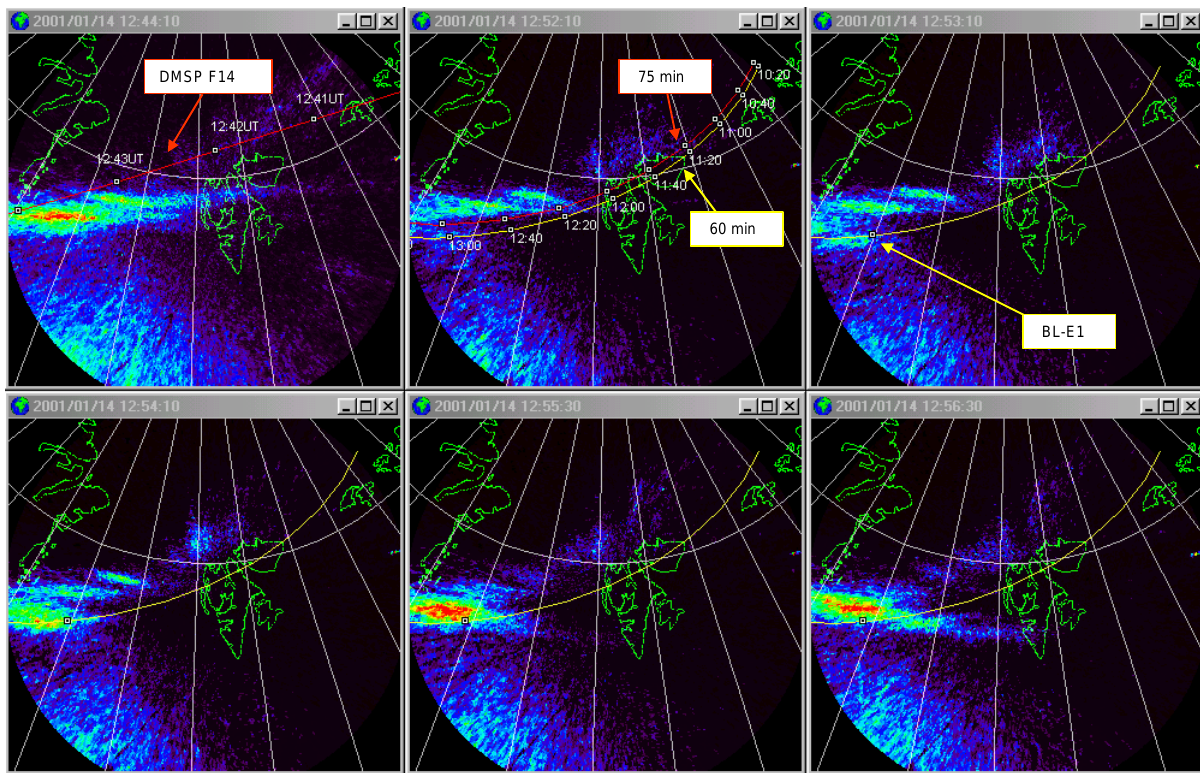
Fig. 5. A sequence of digital all-sky images of the 630.0nm emission taken at Ny- ˚Alesund displayed on a geographical frame of reference. The auroral emission is mapped to an Earth-centred sphere at 250km. Time is given at the top of each frame. The colour scale is linear with increasing intensity from blue to red. The red straight line intersecting the auroral activity near the east coast of Greenland in the 12:44:10UT image marks the trajectory of a DMSP-F14 pass. The red and the yellow curves in the following image represent the nominal ground tracks of Cluster calculated for two different time lags of the IMF observations, 75 and 60min,